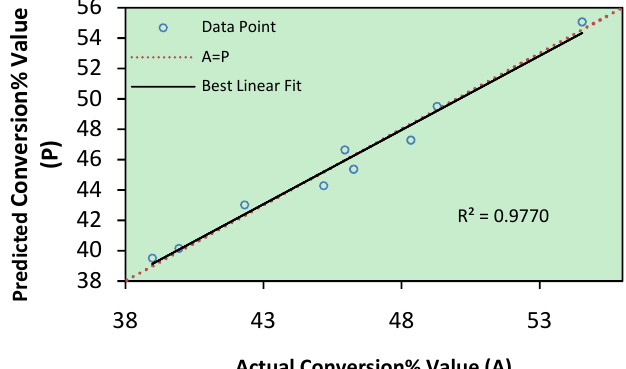
Figure 1. Scatter plot of predicted conversion% value versus actual conversion% value from Taguchi experimental